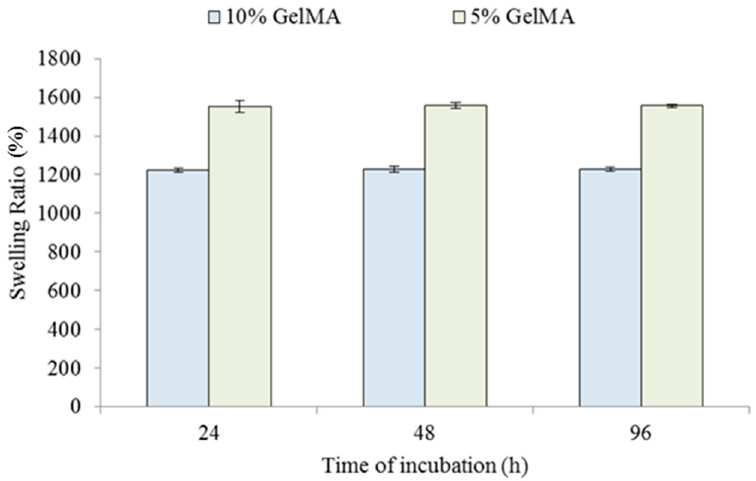
Figure 6. Swelling ratios with an increase in incubation time for 5% and 10% GelMA hydrogels. The error bars indicate the standard deviation